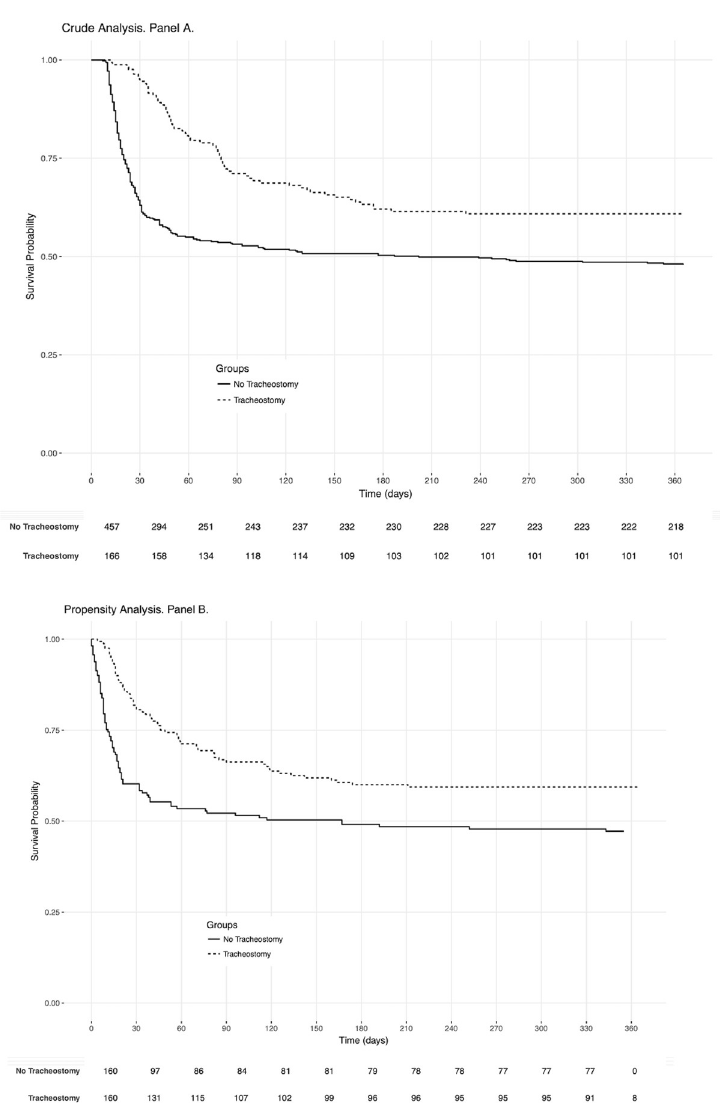
Fig 2. One-year survival curves in patients with prolonged mechanical ventilation duration ( � 10 days) with or without tracheostomy, in crude analysis and in propensity-analysis. Kaplan-Meier curves of one-year mortality in crude analysis (p = 0.001, log-rank test, HR CI95 0.7 [0.5–1.001], p = 0.051, Panel A) and in a propensity-score analysis (HR CI95 0.6 [0.5–0.9], p = 0.02, Panel